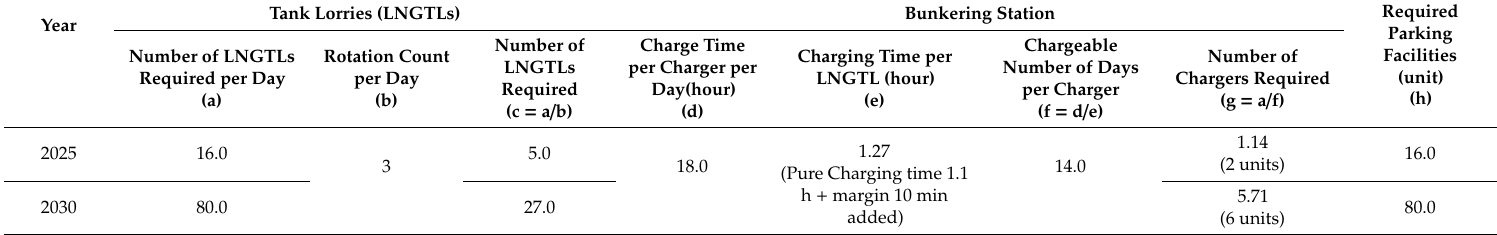
Table A10. Charger for LNGTL and Bunkering Station, Number of Parking Facilities